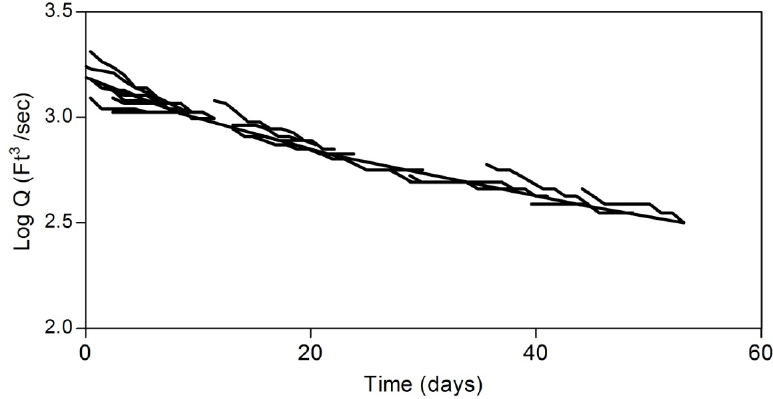
Figure 6. Recession segments and master recession curve (MRC) for the